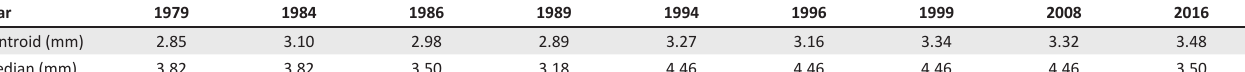
TABLE 4-A1: Calculated centroid (arithmetic mean of all stem diameters recorded per site in mm) and the midpoint (mm) of the size class distribution for each year surveyed at the Grootkolk site in the Nossob riverbed.